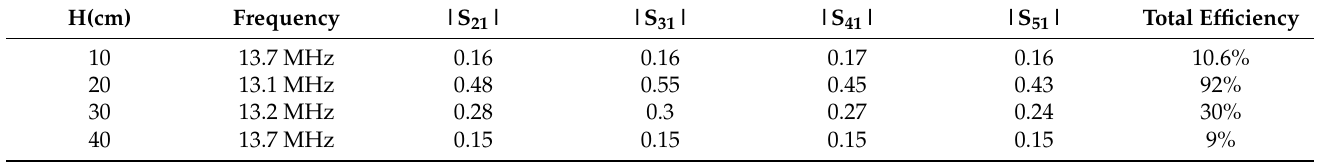
Figure 4. ( a )The scenario of the proposed WPT system refers to the desk. ( b ) Reflection coefficient and transmission loss of the coils. Table 3. The efficiency of the multiple receivers WPT system integrated with metasurface in different H.